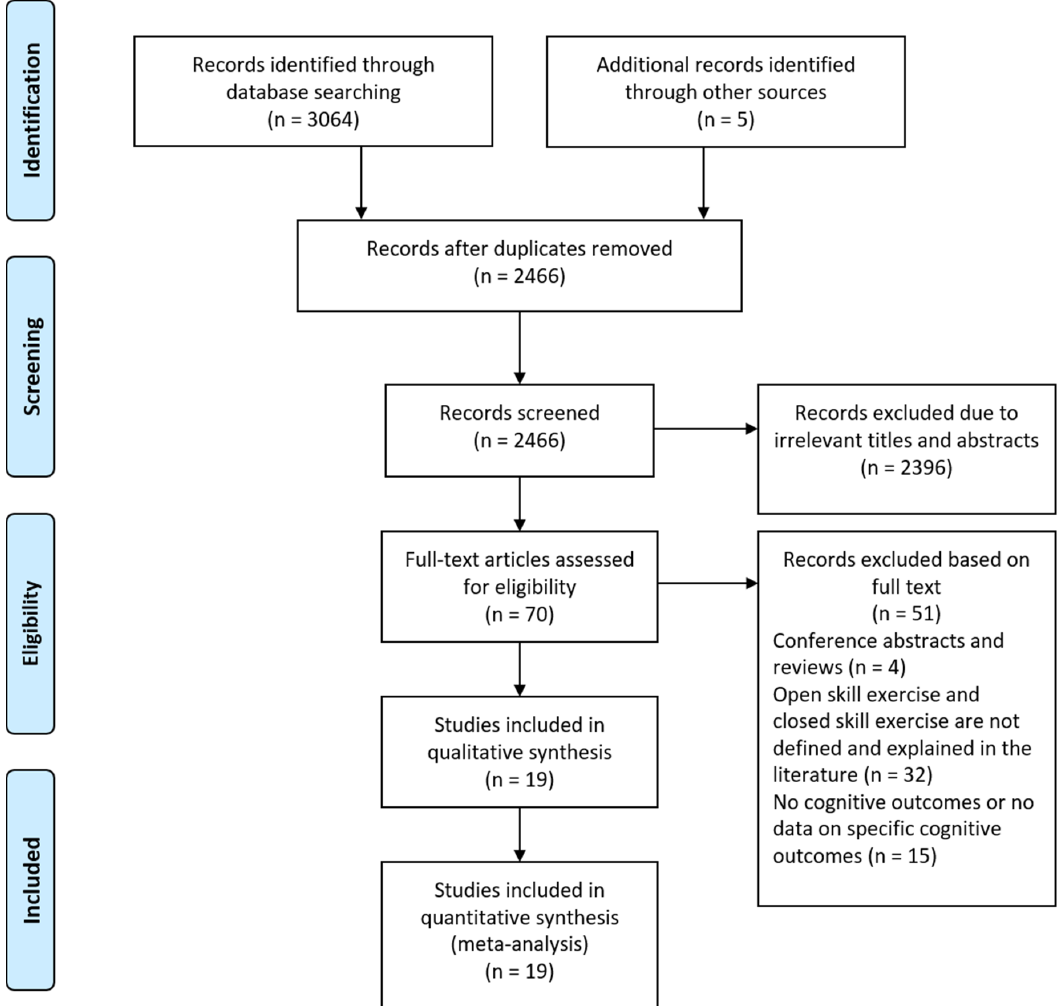
Figure 1. Flowchart of study selection.